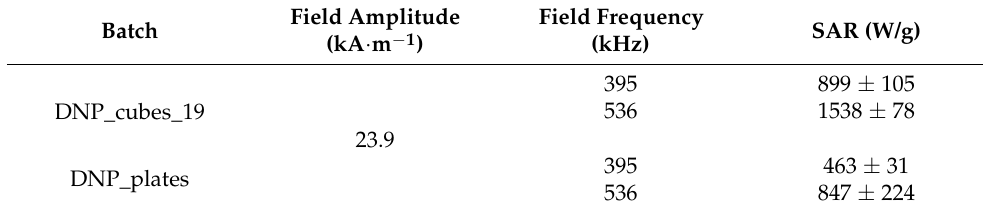
Figure 6. SAR values measured at various Fe 3 -xO 4 concentrations at ( A ) 300 G, 395 kHz and ( B ) 300 G, 536 kHz. Table 5. Mean SAR value of selected batches at two different